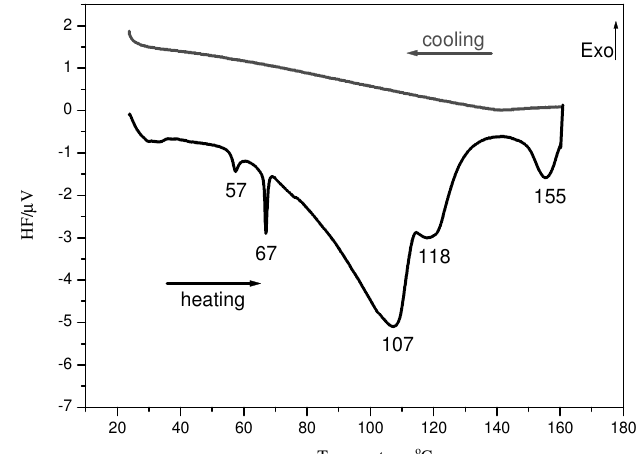
Figure 4. DSC curves obtained upon heating and cooling of (C The second process related to the others endothermic peak observed in the DTA at 227, 242 and 269 °C correspond to a degradation of the obtained phase in a wide temperature range [200-300 °C].